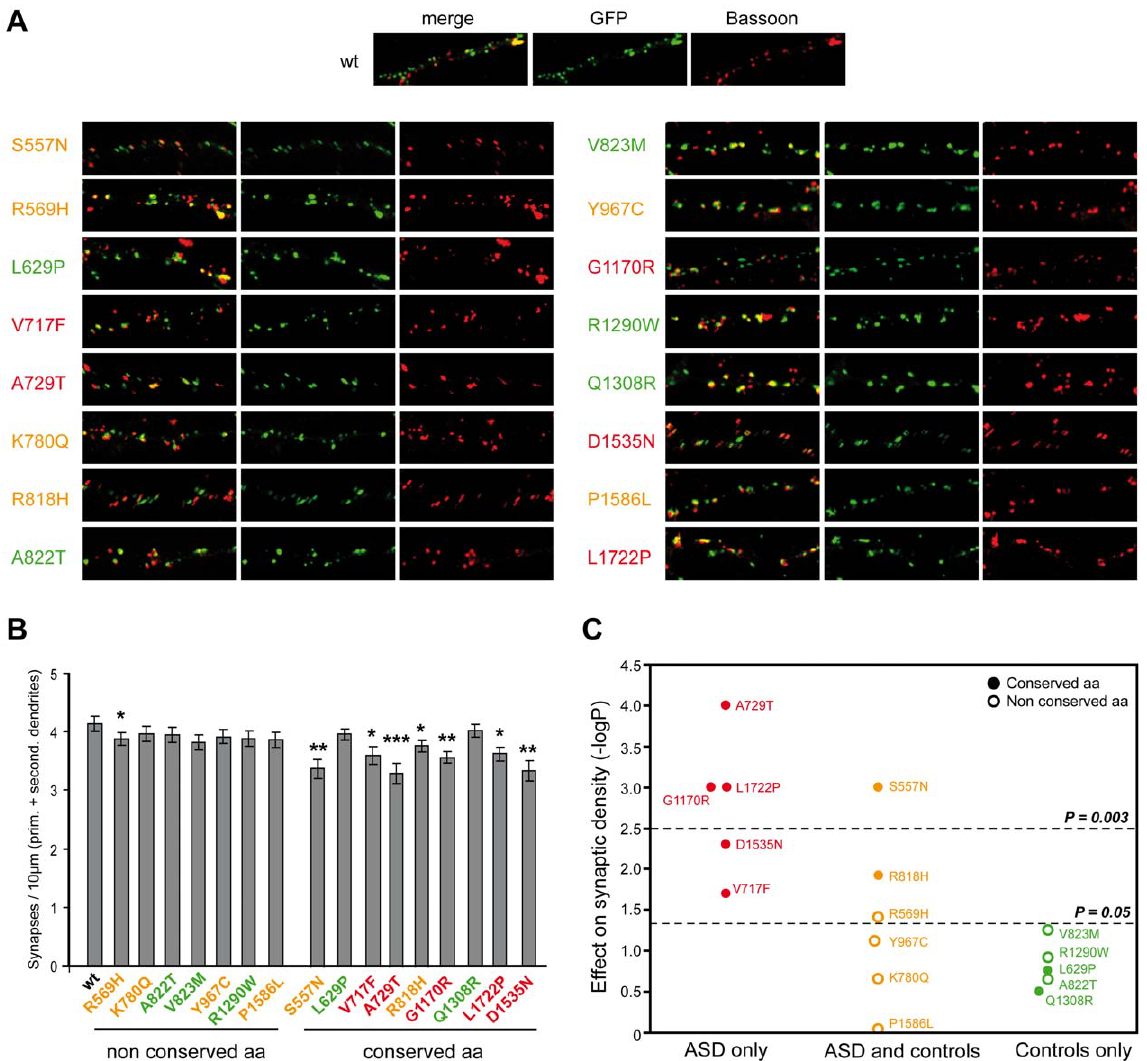
Figure 4. Characterization of the functional impact of SHANK2 mutations in cultured neuronal cells. A. The colocalization of ProSAP1A/ SHANK2 -EGFP (postsynaptic marker) and Bassoon (presynaptic marker) indicated that the mutations did not disturb the formation of SHANK2 clusters at excitatory synapses along the dendrites. B. The quantification of synapse density was performed on 20 transfected hippocampal neurons per construct from at least three independent experiments. The majority of the ProSAP1A variants affecting a conserved amino acid among SHANK proteins reduced significantly the synaptic density compared with the variants that affect amino acid non conserved among SHANK proteins (Mann- Whitney U-test: n WT =20, n mut =20; U S557N =82.5, p S557N =0.001; U R569H =124, p R569H =0.04; U L629P =149, p L629P =0.17; U V717F =114, p V717F =0.02; U A729T =73, p A729T =0.000; U K780Q =154, p K780Q =0.221; U R818H =108, p R818H =0.012; U A822T =154.5, p A822T =0.224; U V823M =129, p V823M =0.056; U Y967C =134, p Y967C =0.076; U G1170R =78, p G1170R =0.001; U R1290W =142, p R1290W =0.121; U Q1308R =162, p Q1308R =0.314; U D1535N =97, p D1535N =0.005; U P1586L =137, p P1586L =0.910; U L1722P =79, p L1722P =0.001, *p , 0.05, **p , 0.01, ***p , 0.001). C. Effect of the variants on synaptic density. The y-axis represents 2 log P compared to WT (P obtained with Mann-Whitney test). After Bonferroni correction for 16 tests, only P values , 0.003 were considered as significant. Variants represented in red were specific to ASD, in orange were shared by ASD and controls, and in green were specific to the controls. Open circles and filled circles represent non conserved and conserved amino acids, respectively. Prim, primary; second,